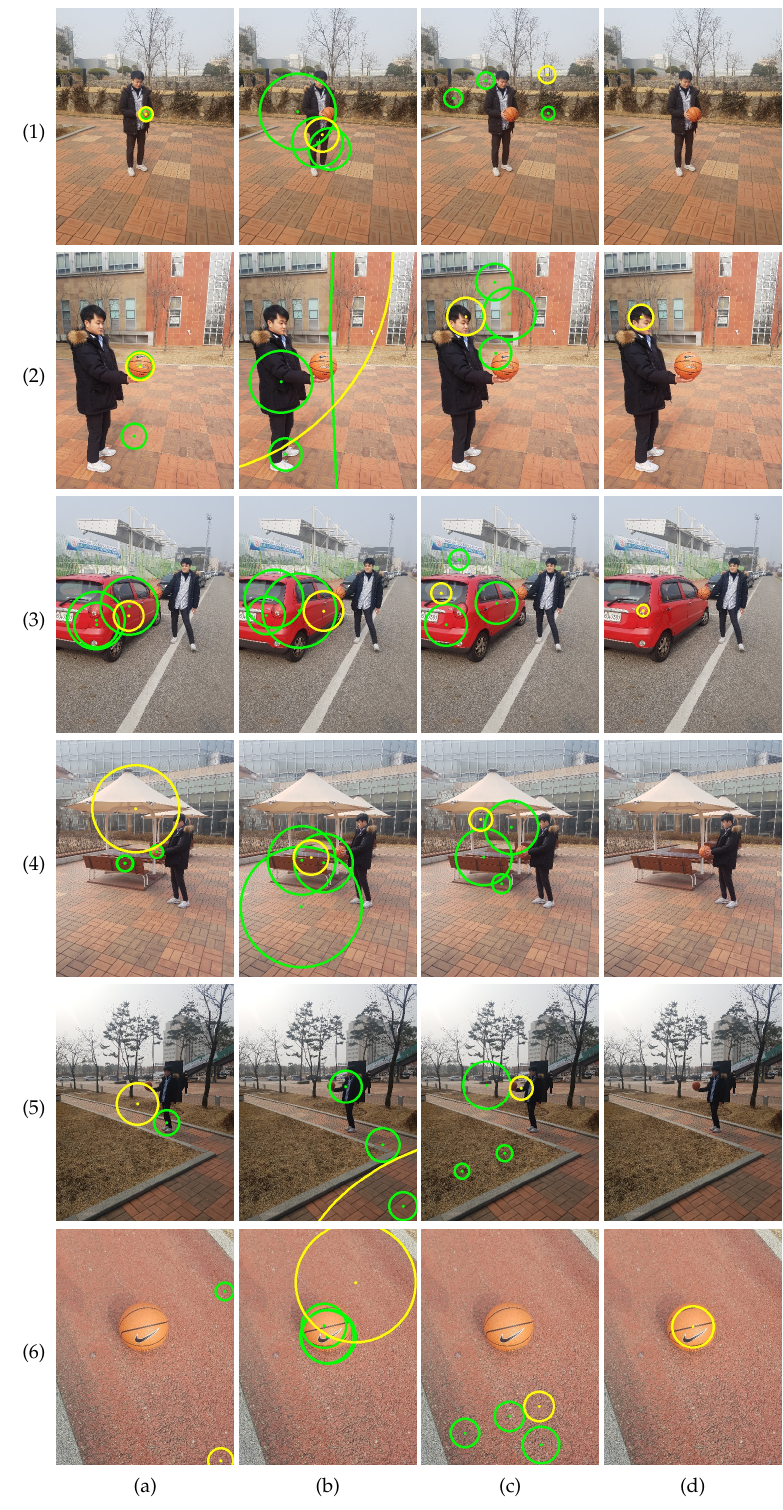
Figure 10. Top four circles detected by the methods (basketball set). ( a ) Proposed method. ( b ) Kwon et al. [21]. ( c ) CHT [36]. ( d ) EDCircles [44]. From ( a – d ), the best circles are drawn in yellow, while the remaining circles are drawn in green. Some circles have similar centers and radii in ( a , b ), so the numbers of circles in the images may seem less than four. Best viewed in